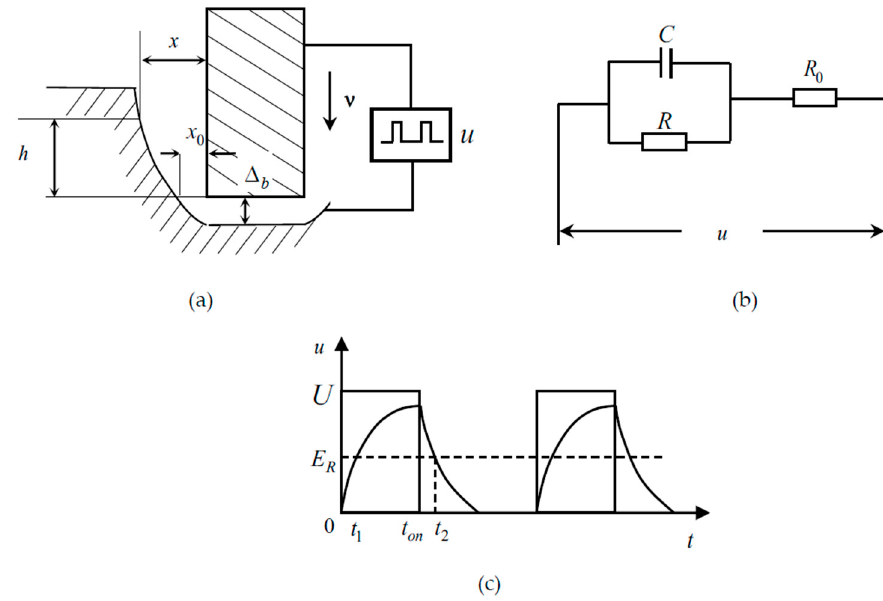
Figure 2. Process and equivalent circuit of electrochemical drilling (ECD) by ultra-short voltage pulse: ( a ) schematic diagram; ( b ) equivalent circuit diagram; and ( c ) waveform of the reaction voltage. According to the transient response analysis of the circuit [5,14], the reaction voltage between cathode and anode is u 1 . By B